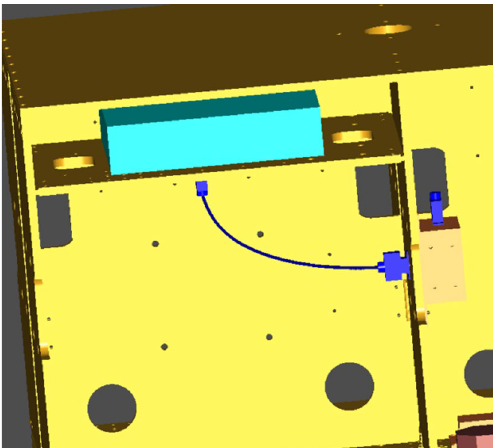
Figure 16. Single cable wiring.